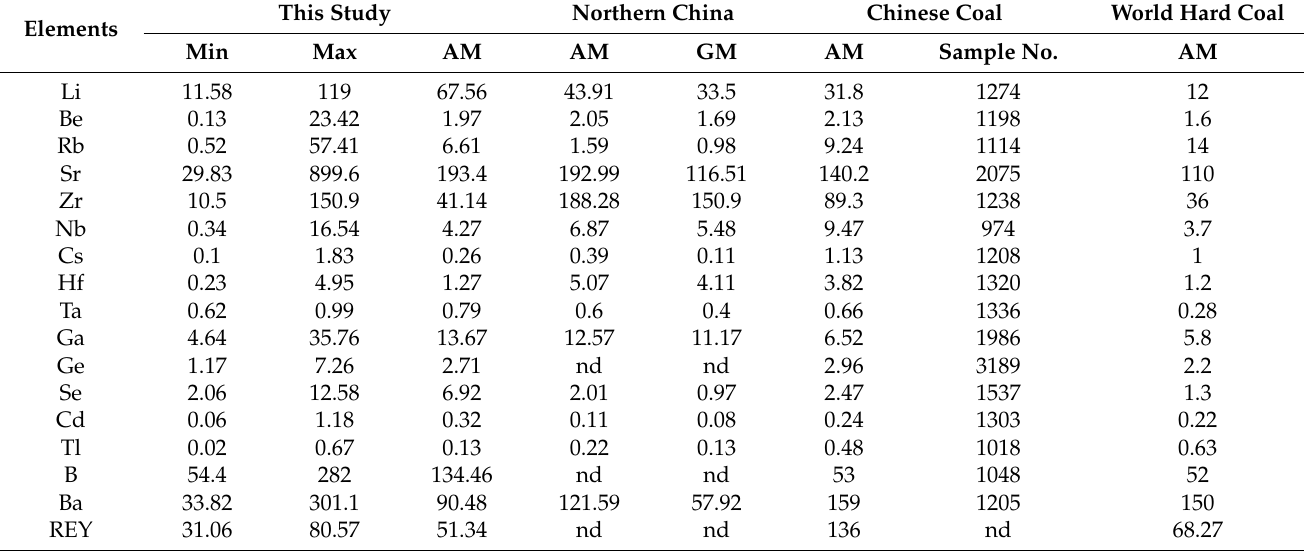
Table 4. Test results of TREs in coal of the Shanxi Formation in Huainan ( µ